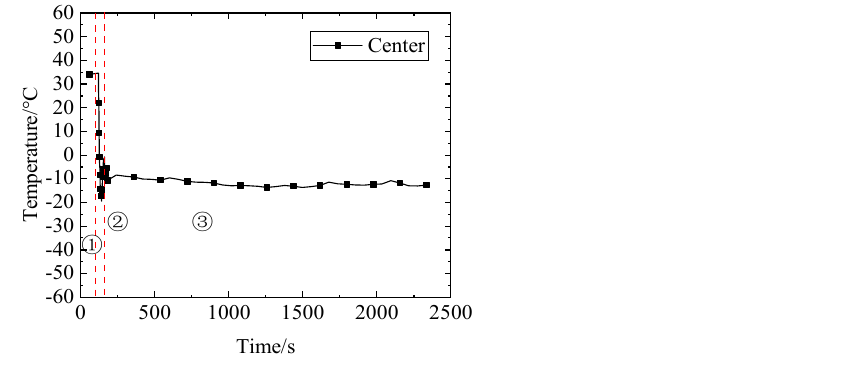
Figure 17. Change curve of temperature over time with the decrease of 40 K under 10,000 W/m 2 heat flux.